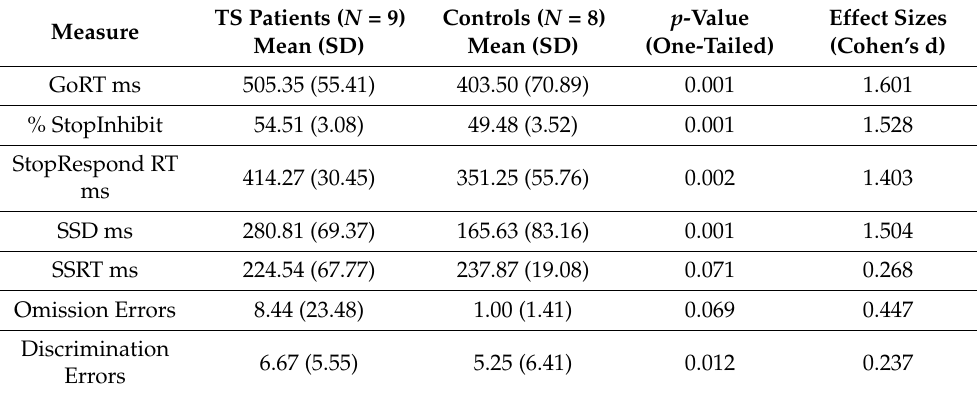
Table 2. Means and standard deviations (in parentheses) of the measures on the stop signal task for patients with Tourette Syndrome (TS) before deep brain stimulation (DBS) surgery and healthy controls. RT = reaction time, SSD = stop signal delay, SSRT = stop signal reaction time.